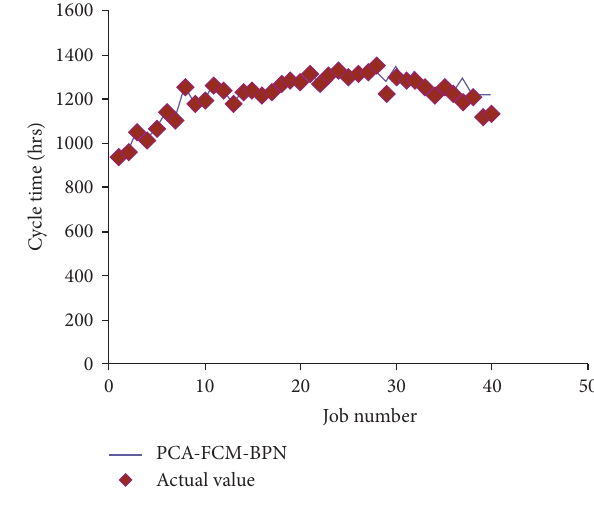
Table 7: The forecasting performances.